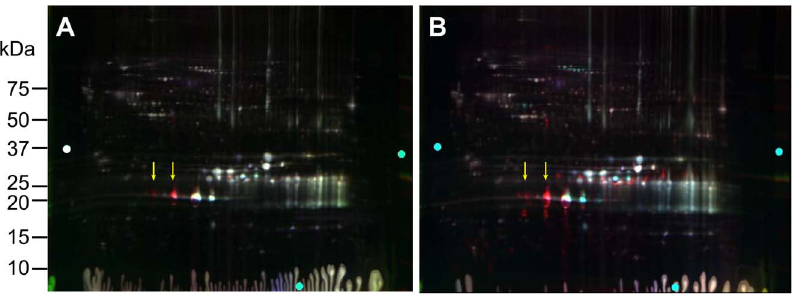
Figure 1. 2D-DIGE analysis of proteomic changes in whole lenses of 2-day-old mice with knock-in of the a A-R49C mutation. (A) 2D gel of cyanine dye-labeled lens proteins derived from wild-type sample 1 (WT1) proteins labeled with Cy2, WT2 proteins labeled with Cy3, and a A- R49C heterozygous proteins labeled with Cy5. (B) 2D gel of cyanine dye-labeled lens proteins derived from WT1 proteins labeled with Cy2, WT2 proteins labeled with Cy3, and a A-R49C homozygous proteins labeled with Cy5. Protein spots that were selected for analysis from the gels shown in (A) and (B) are shown in Fig. S1 in File S1 and were identified by tandem mass spectrometry and Mascot searches. Quantitative image analysis and mass spectrometry data for the identified proteins are listed in Table 1. Arrows indicate the shift in position of the a A-crystallin bands (red) to a more acidic pI with the mutation.